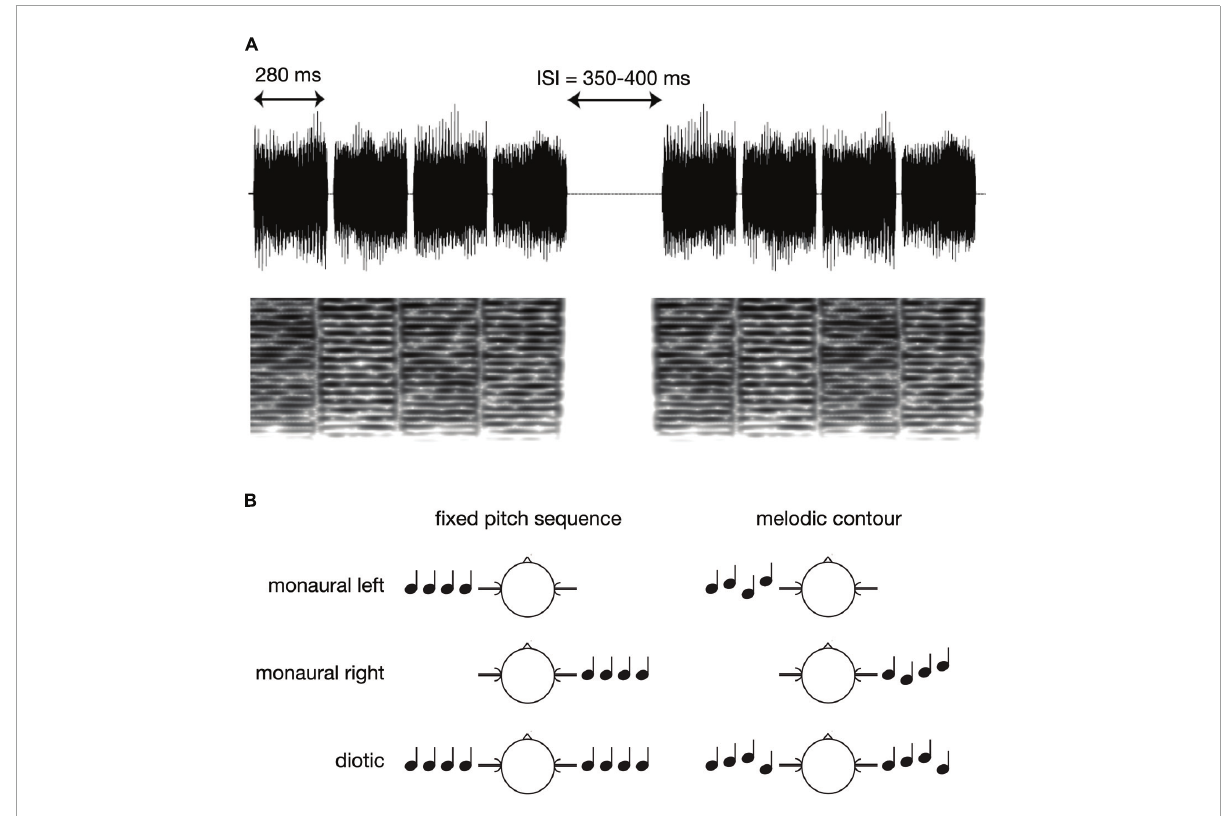
FIGURE1 Schematic overview of the experimental paradigm. (A) Examples of the IRN sound waveforms in the melodic contour condition, together with the corresponding spectrograms. (B) Presentation of fixed pitch sequences vs. melodic contours in the monaural left, monaural right, or diotic